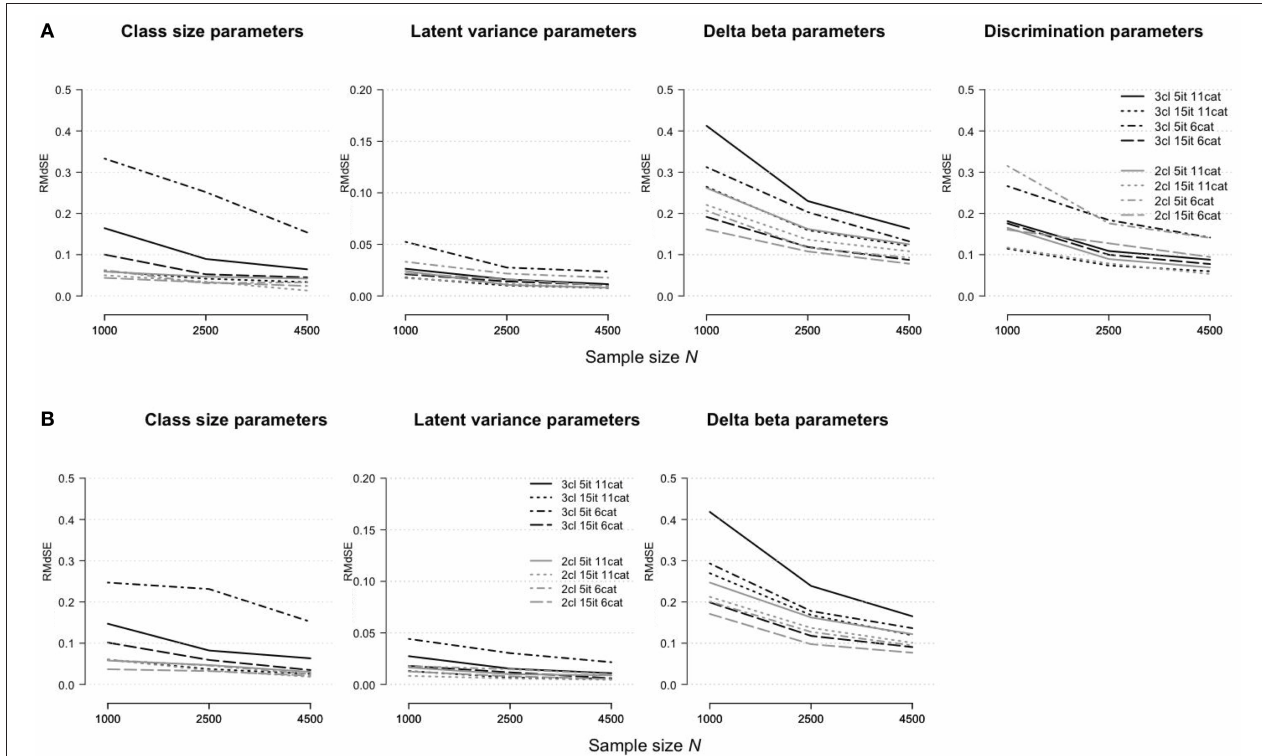
FIGURE 4 | Root median squared error for parameter estimates in (A) the rmGPCM-3 and (B) the mPCM-3 under further data